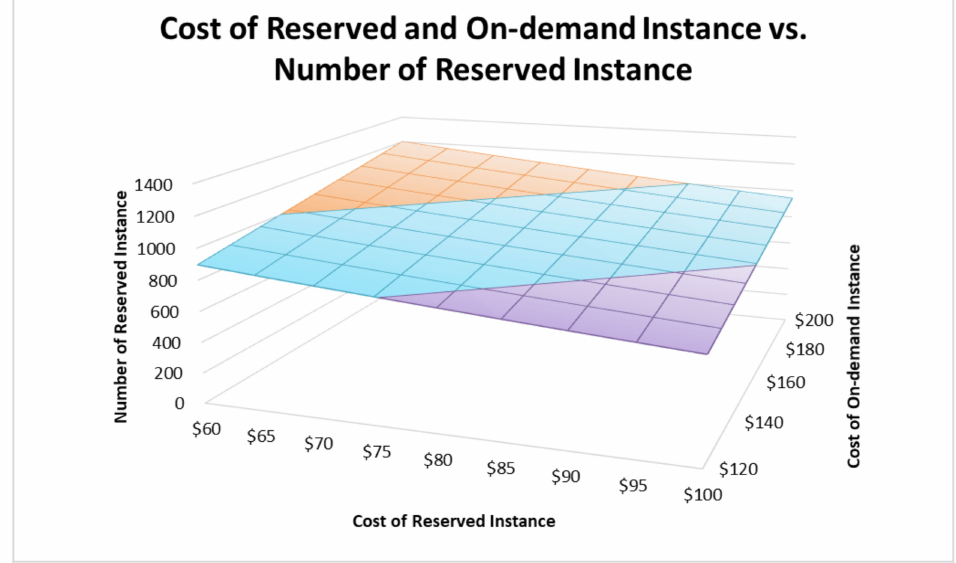
Figure 6. Costs of Reserved Instance and On-demand Instance vs. Number of Reserved